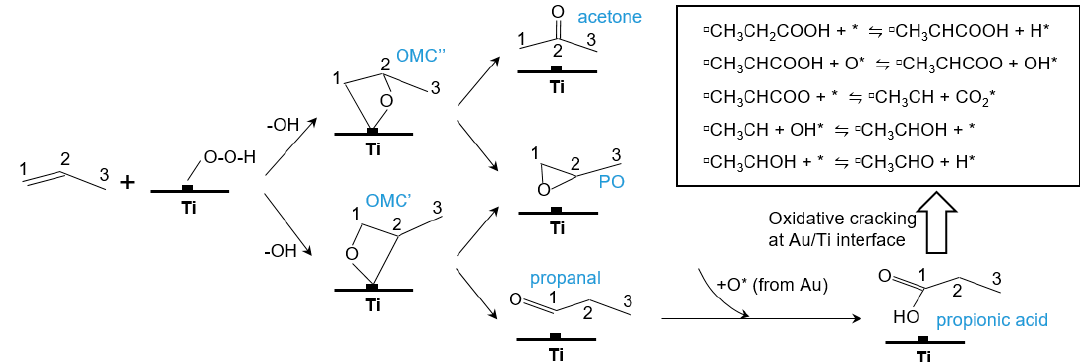
Figure 10. Reaction network at the Au/Ti interface. The * symbol represents a bare Au site, and □ represents a bare interfacial Ti site that is in contact with Au nanoparticles (for clarity, Au nanoparticle is not shown here). The species attached to * or □ indicates one Au surface-bound species or one Ti surface-bound species, respectively [141]. Copyright © 2018 Elsevier Ltd.